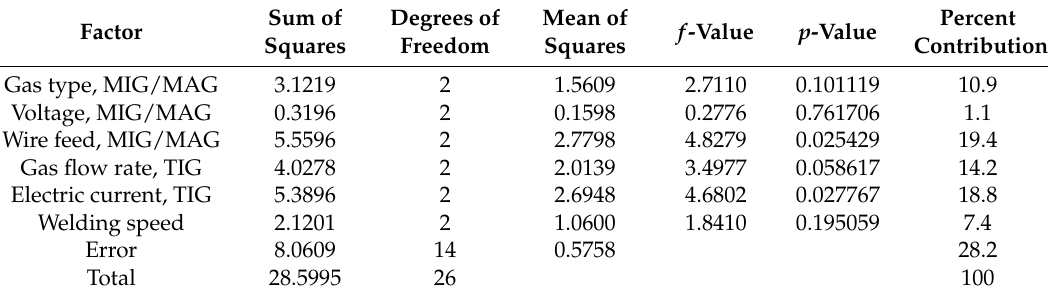
Table 6. Variance analysis for the bead height of the